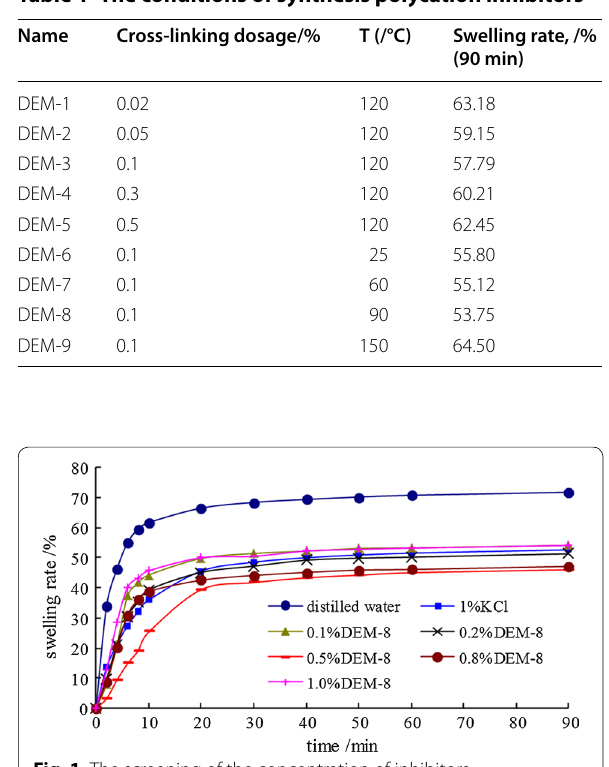
Table 1 The conditions of synthesis polycation inhibitors